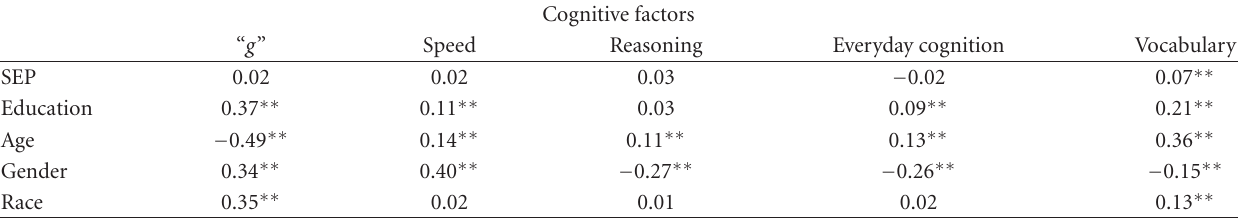
Table 5: Standardized coe ffi cients ( β ) for prediction of cognitive domains by SEP and covariates. ∗∗ p < 0 . 01. Cognitive factors “ g ” Speed Reasoning Everyday cognition Vocabulary − 0.02 0.07